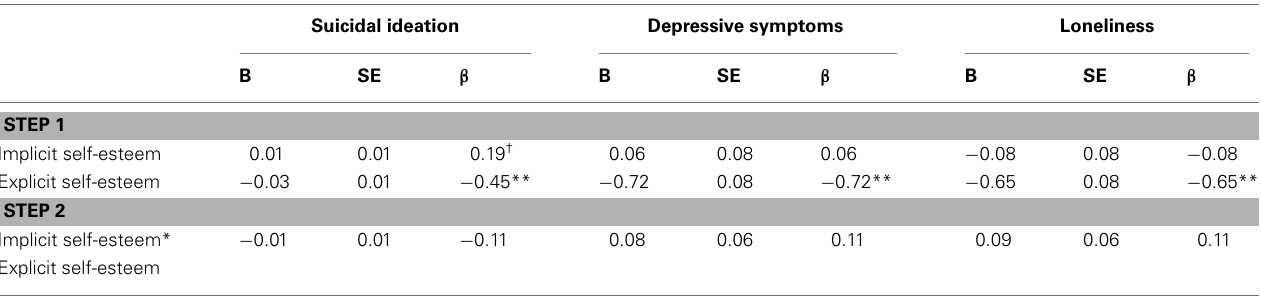
TableA1 | Hierarchical multiple regression analyses: associations of explicit self-esteem, implicit self-esteem (Brief-IAT), and the interaction between implicit and explicit self-esteem with suicidal ideation, depressive symptoms, and loneliness. Suicidal ideation Depressive symptoms Loneliness